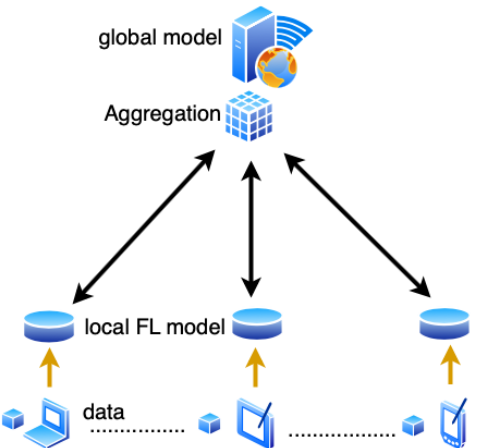
Figure 2. Basic Federated Learning Architecture: Users use local data to train local models, the local models are used to update the global model in the base station. The aggregated global model is passed to the local models for further training. These steps are repeated until the global model